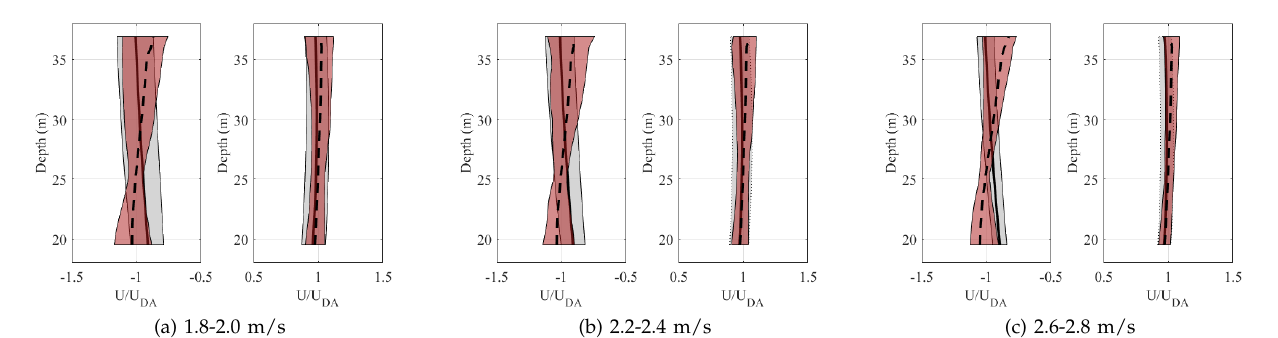
Fig. 4. For the near surface position, a range of shear profiles for three different disk averaged velocities, for varying measured profiles (red band), varying predicted profiles (grey band), mean measured (dashed black) and mean predicted (solid black).